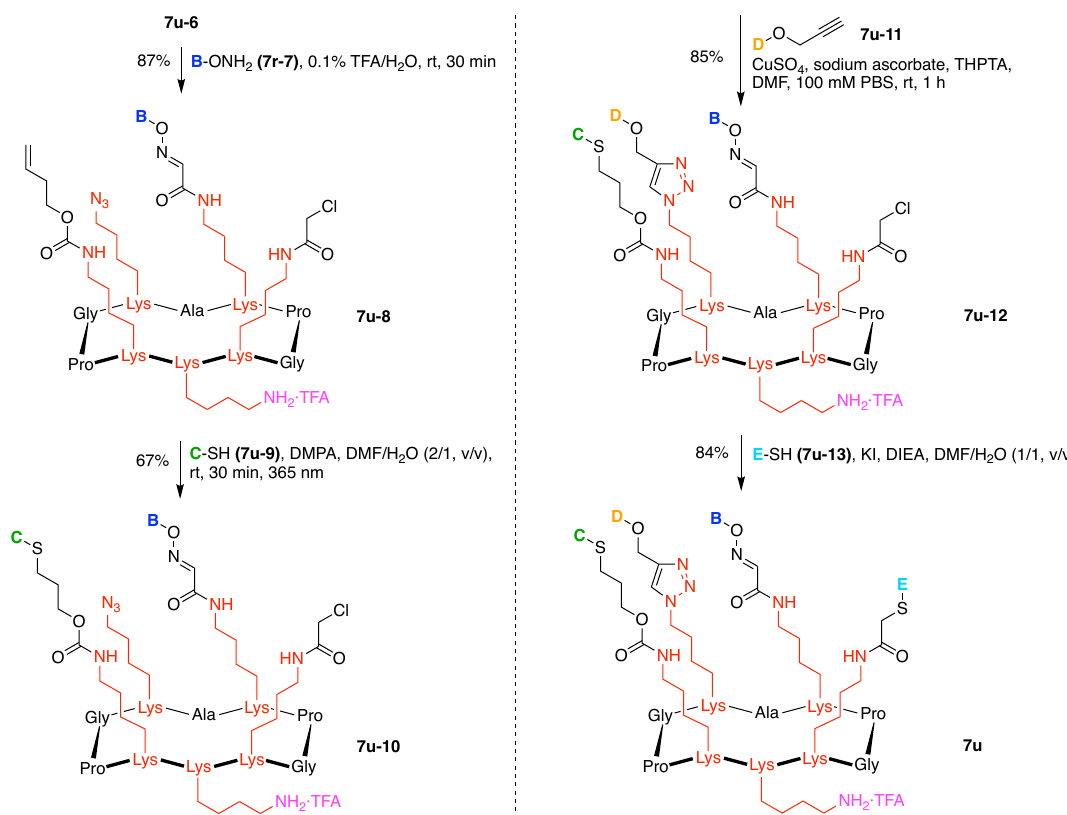
Figure 23. Rational introduction of B, C, D, E units on a decapeptide scaffold. Alternatively, sequential one-flask attachment of the carbohydrates was executed in the same order and under similar conditions with simple adjustments of both pH and solvent in the crude mixture. The reactivity and reaction efficiency were not dependent on the concentration used, and similar reaction times to the stepwise procedures were needed for complete conjugation via the sequential one-flask method. Final purification by reversed-phase high-performance liquid chromatography provided 7u in 47% overall